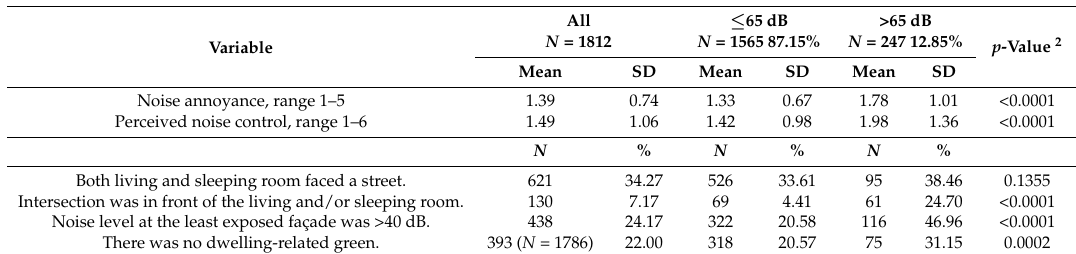
Table 2. Noise annoyance, perceived control and lack of dwelling-related environmental resources stratified by noise exposure N = 1812 1